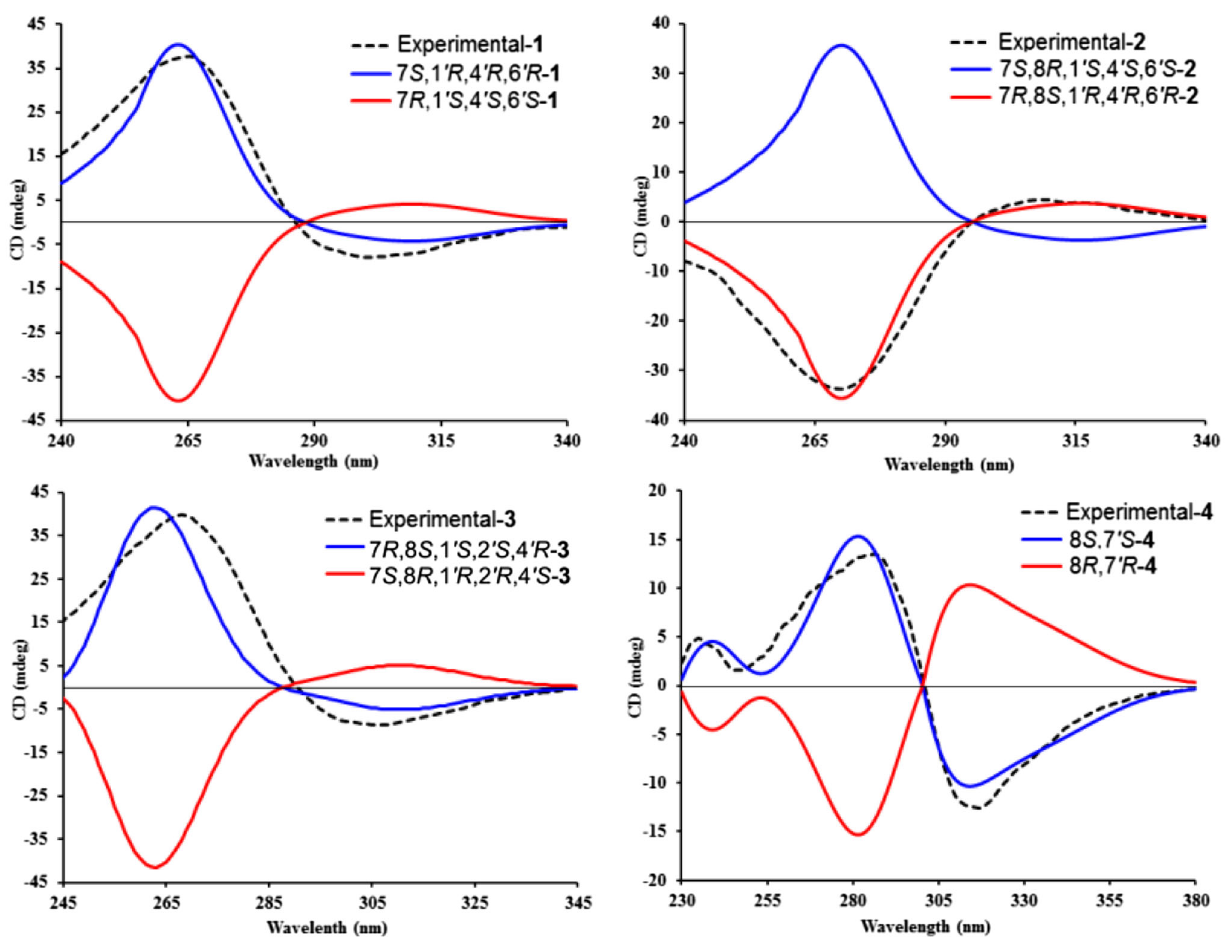
Fig. 3 Calculated and experimental ECD spectra of 1 –